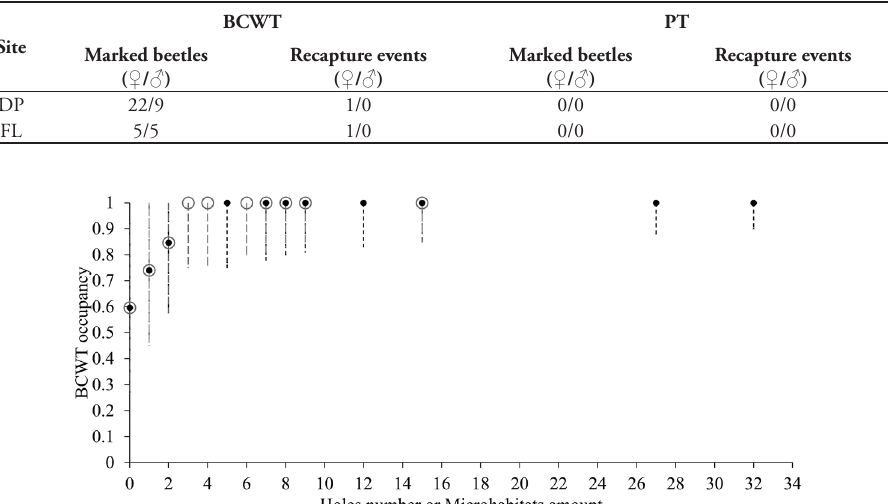
Figure 9. BCWT occupancy data. BCWT occupancy of O. eremita during 2015 in relation to the number of holes (grey empty circles) and microhabitat amount (black dots). Vertical bars indicate the standard